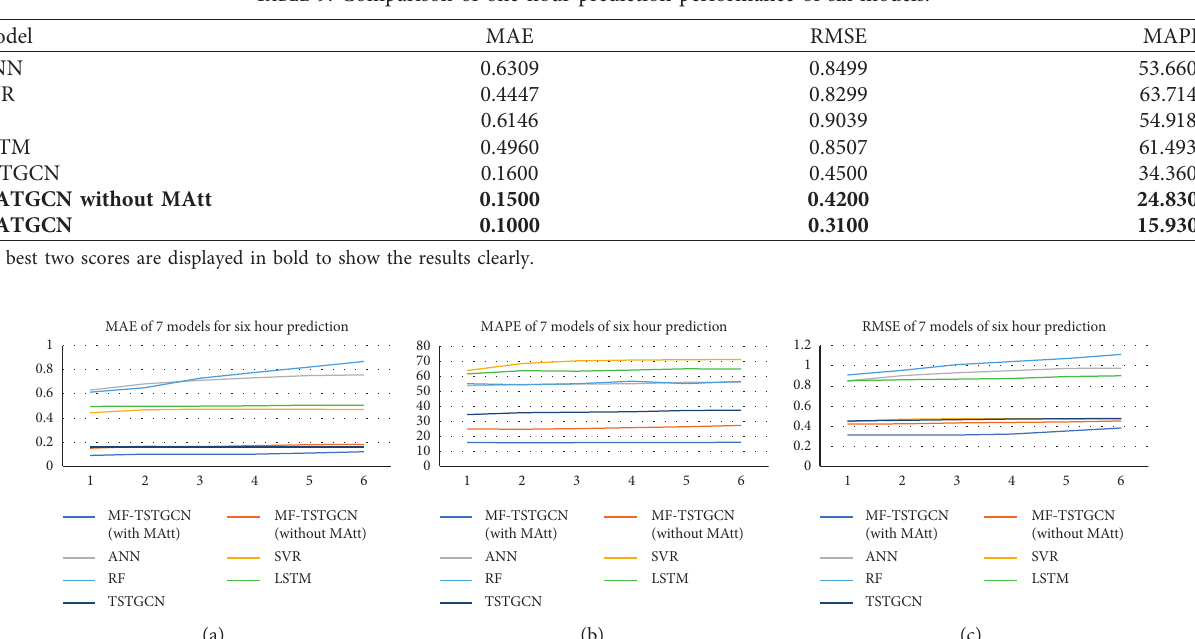
Table 9: Comparison of one-hour prediction performance of six